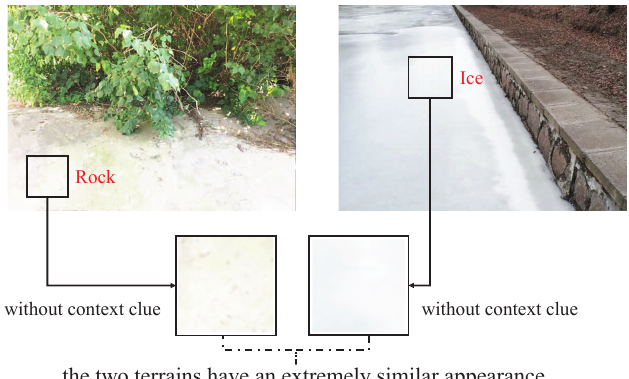
Figure 4. In the local image, without context clues, an overexposed rock and ice have are extremely similar in